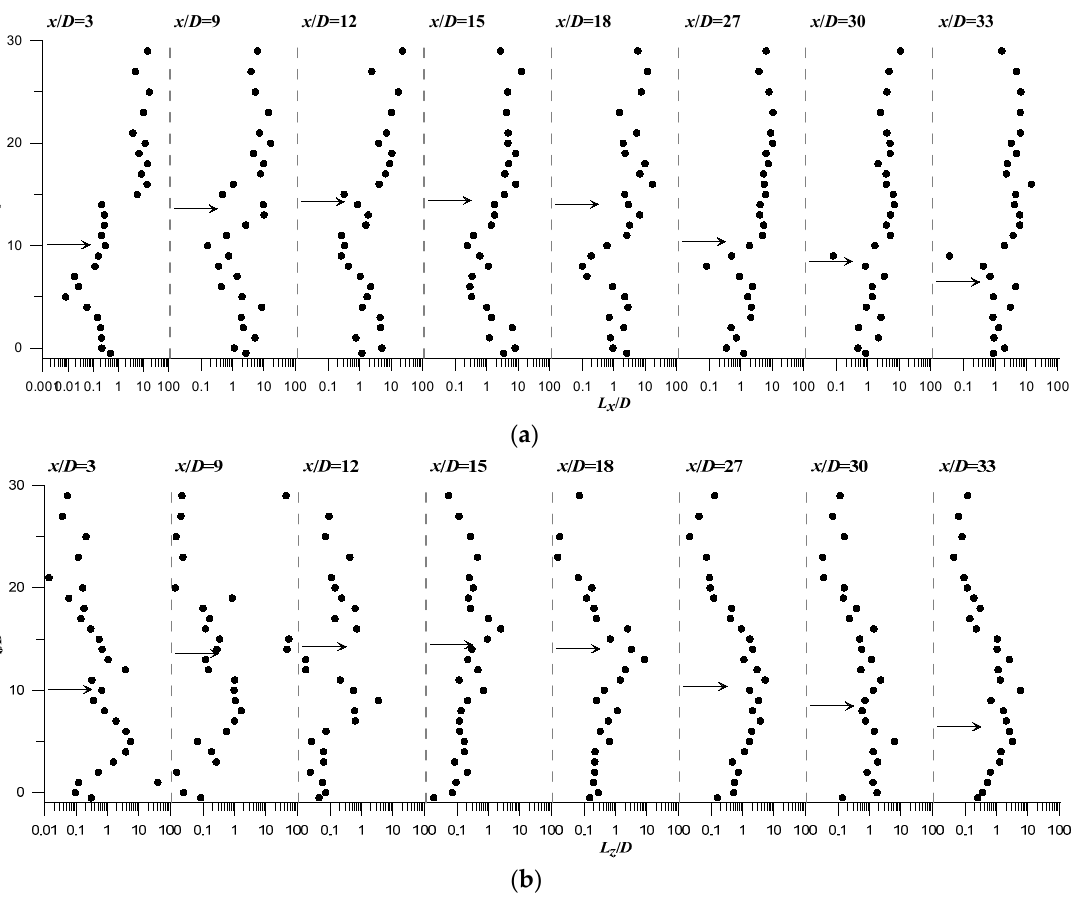
Figure 14. Vertical profiles of the normalized turbulent length scales at different downstream positions x / D at the plane of flow symmetry ( y = 0) of run R2: ( a ) L x / D ; ( b ) L z / D .